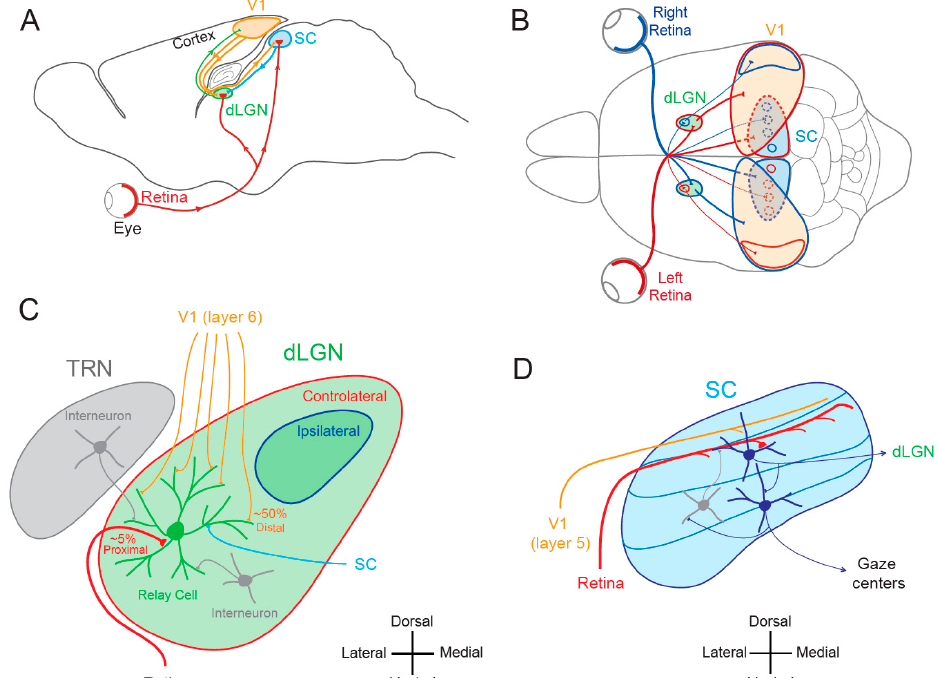
Figure 1. Visual pathways. ( A ) Sagittal view of the rodent visual system. V1, primary visual area; SC, superior colliculus; dLGN, dorsal lateral geniculate nucleus. ( B ) Superior view of the rodent visual system. Red, visual inputs from the left eye. Blue, visual inputs from the right eye. ( C ) Simplified synaptic organization of visual inputs to rodent dLGN. The relay cell receives 3 types of excitatory inputs: (1) small amount (~5%) of functionally powerful contralateral inputs from the retina on proximal dendrite (red), (2) numerous (~50%) but functionally weak feed-back inputs from V1 (orange) on distal dendrites and (3) from the SC (light blue) on medial and distal dendrites. In addition, it is inhibited by interneurons located in the TRN (thalamic reticular nucleus) and in the dLGN (grey). ( D ) Principal inputs and outputs of rodent SC neurons. In the superficial layer, SC neurons receive excitatory inputs from the retina (red) and from V1 (orange) and an inhibitory feed-back (grey) from interneurons located deeper in the SC. Superficial excitatory neurons contact deeper premotor neurons and neurons in the dLGN. Premotor neurons in the deep layer feed gaze centers of the brain. Adapted from [11].